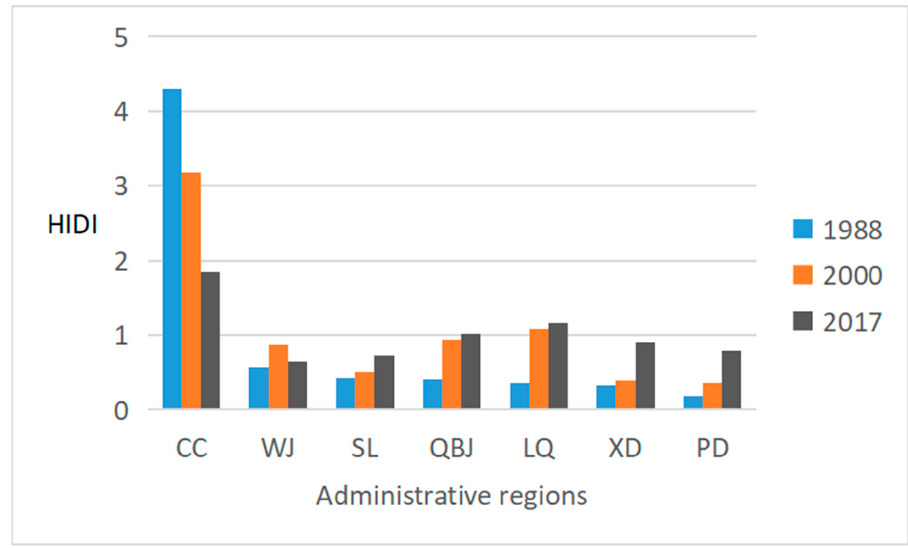
Figure 6. The HIDI of each analysis unit in the main urban area of Chengdu in 1988, 2000, and 2017. 3.4. Analysis of the Impact of Landscape Pattern Changes on the Heat Islands